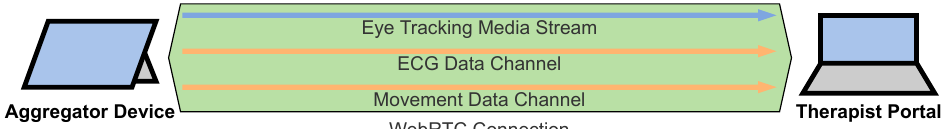
Figure 15. Sensor data are carried from the Aggregator Device to the Therapist Portal within Media Streams and Data Channels of a P2P WebRTC